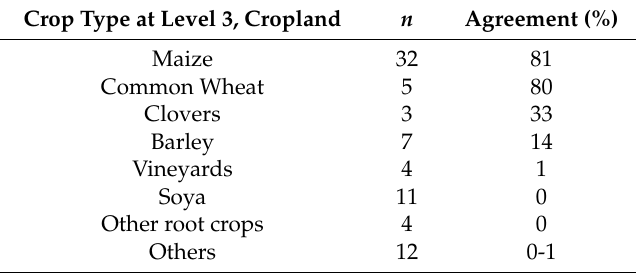
Table 7. An example of land cover type agreement at level 3 for the main class “Cropland”, sorted by percentage agreement between FotoQuest Austria and LUCAS. Number of observations ( n ) is shown.